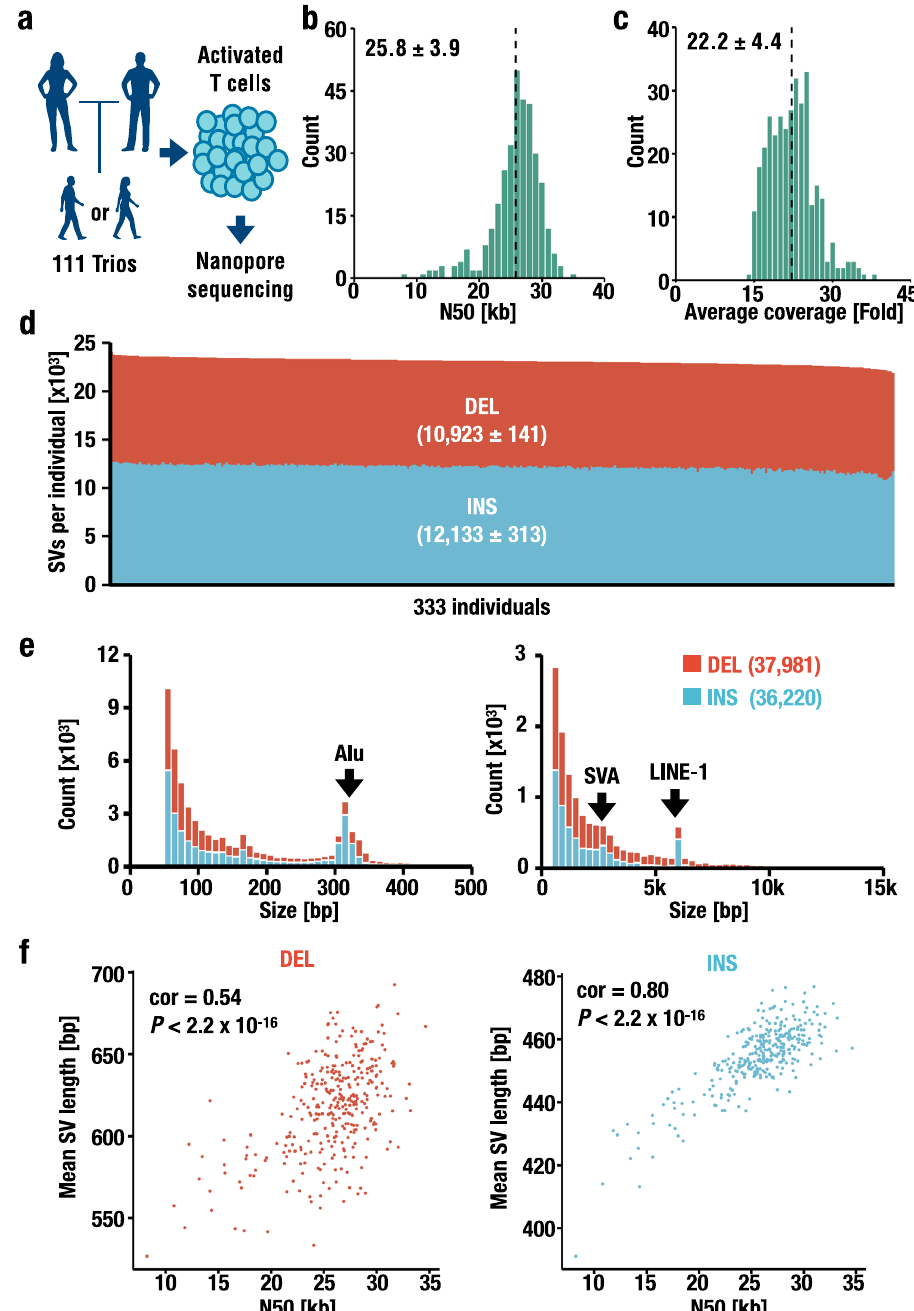
Fig. 2 Study design and statistics of the trio-based nanopore sequencing. a Design of the SV analysis in this study. Activated T cells were established from 333 individuals comprising 111 trios and subjected to whole-genome sequencing using a nanopore sequencer. b , c Distribution of read length N50 ( b ) and average coverage of aligned reads ( c ). The dotted lines show the mean values, and the mean ± SD is indicated in the panel. d Number of DEL (red) and INS (blue) SVs located on autosomes per individual. Mean ± SD is indicated in parentheses. e Size distribution of the DELs (red) and INSs (blue). The left and right panels indicate the distribution of SVs with sizes from 50 to 500 bp (bin = 10 bp) and sizes from 500 bp to 15 kb (bin = 300 bp), respectively. Notable peaks due to transposable elements (Alu, SINE/VNTR/Alu [SVA], and LINE-1) are shown as arrows. The numbers of DELs (red) and INSs (blue) are shown in parentheses. f Scatterplot showing the relationship between the N50 length and mean DEL (red) and INS (blue) length. The Pearson correlation coef fi cient (cor) and P values are shown ( n =